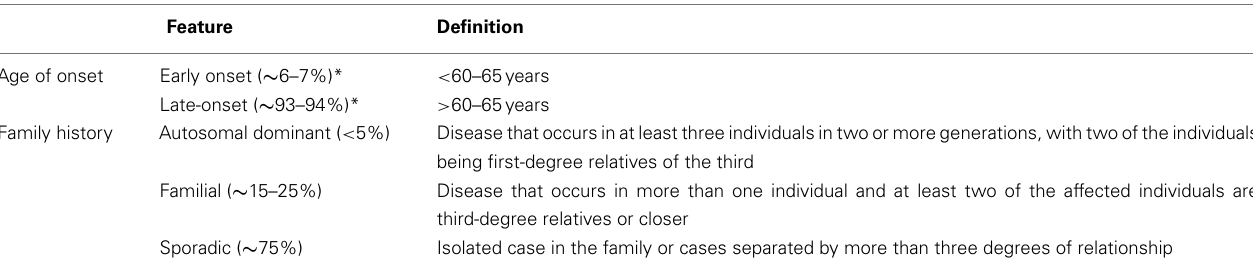
Table 1 |Alzheimer Disease Genetics Division according to theAmerican College of Medical Genetics and the National Society of Genetic